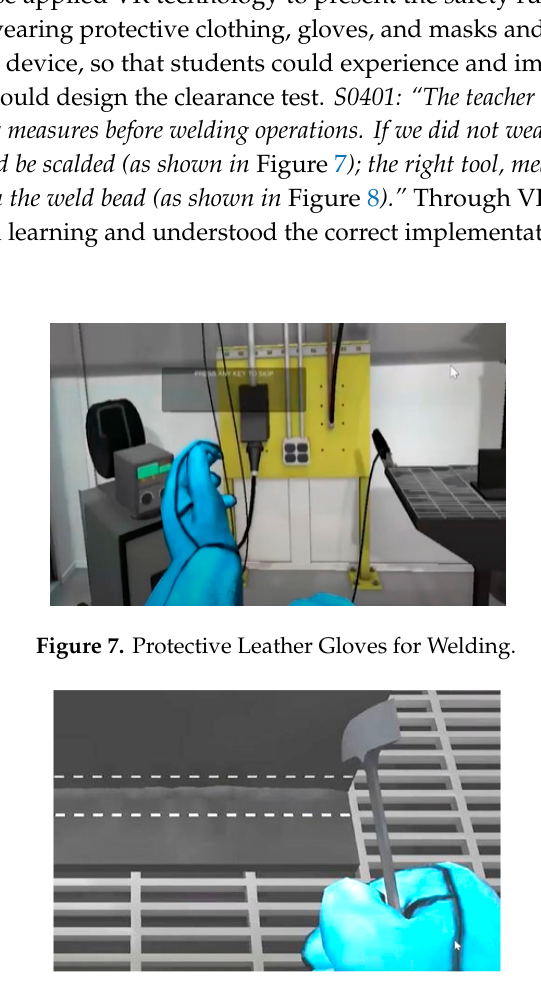
Figure 6. Related Tools for Welding.